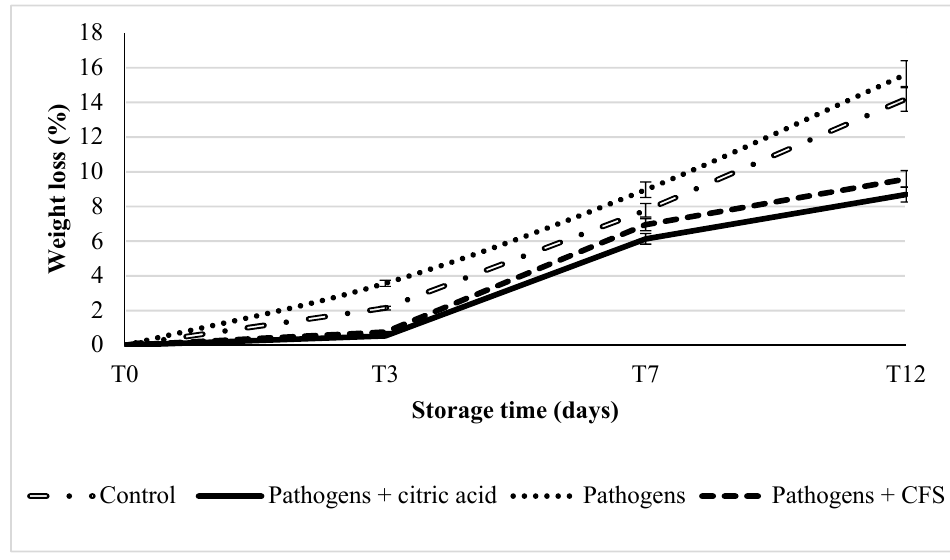
Figure 3. Weight loss (%) in pomegranate aril samples was differently treated during storage at refrigerated conditions.